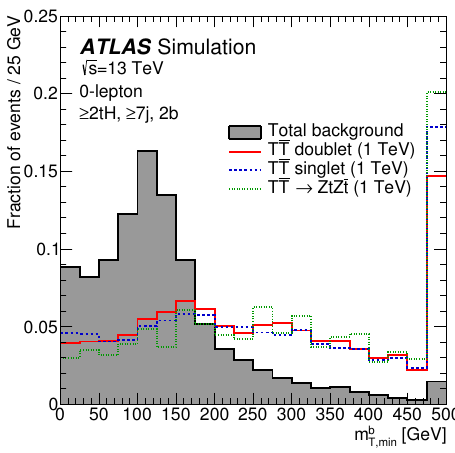
Figure 4. Comparison of the distribution of the minimum transverse mass of E miss and any of the T three (or two, in events with exactly two b -tagged jets) leading b -tagged jets in the event ( m b ), T, min between the total background (shaded histogram) and several signal scenarios considered in this search. The selection used corresponds to events in the ( 2tH, 7j, 2b) region of the 0-lepton (cid:21) (cid:21) channel. The signals shown correspond to T (cid:22) T production in the weak-isospin doublet and singlet scenarios, and in the ( T Zt ) = 1 case, assuming m T = 1 TeV. The last bin in the (cid:12)gure B ! contains the